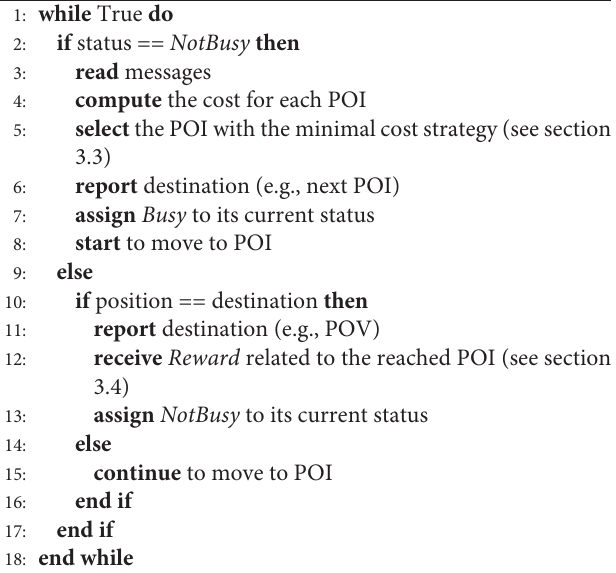
Algorithm 1 Pseudo-code of the mission execution control algorithm embedded in each UAV.